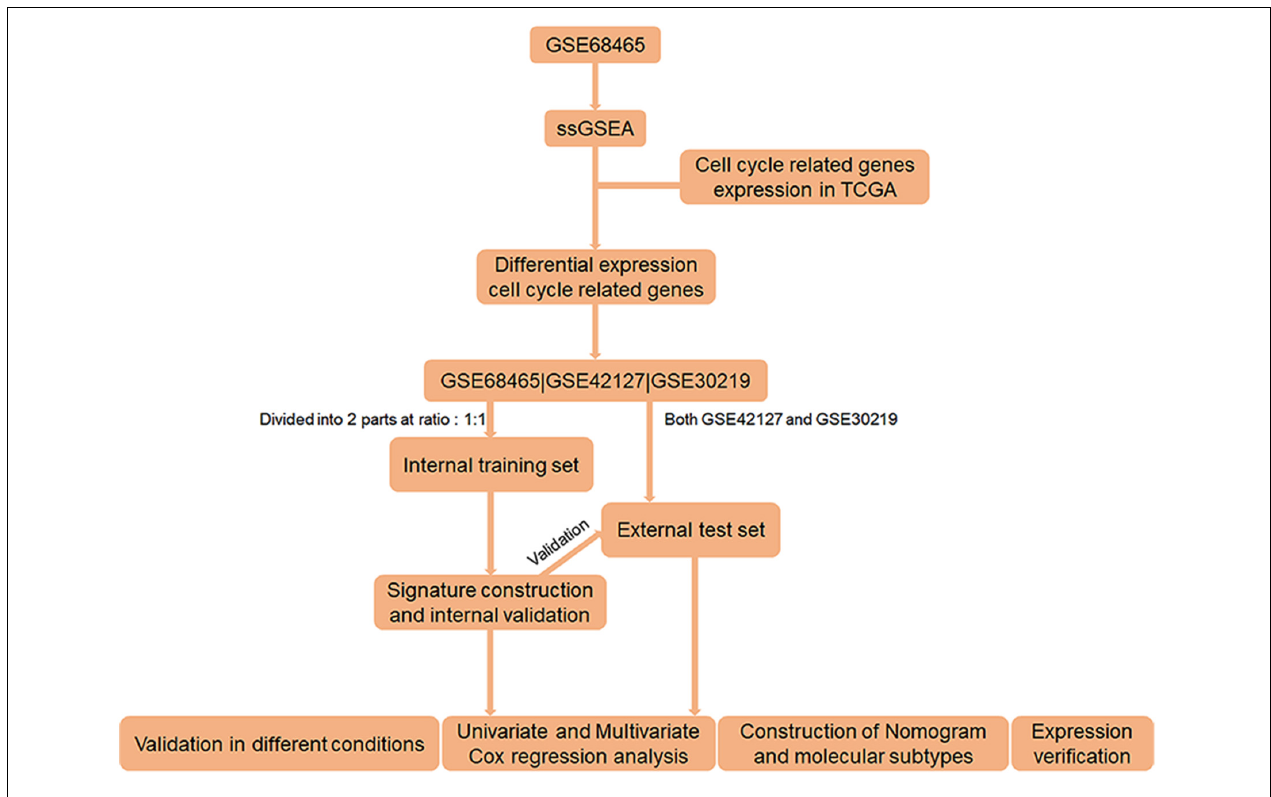
FIGURE 1 | Flow chart of the entire